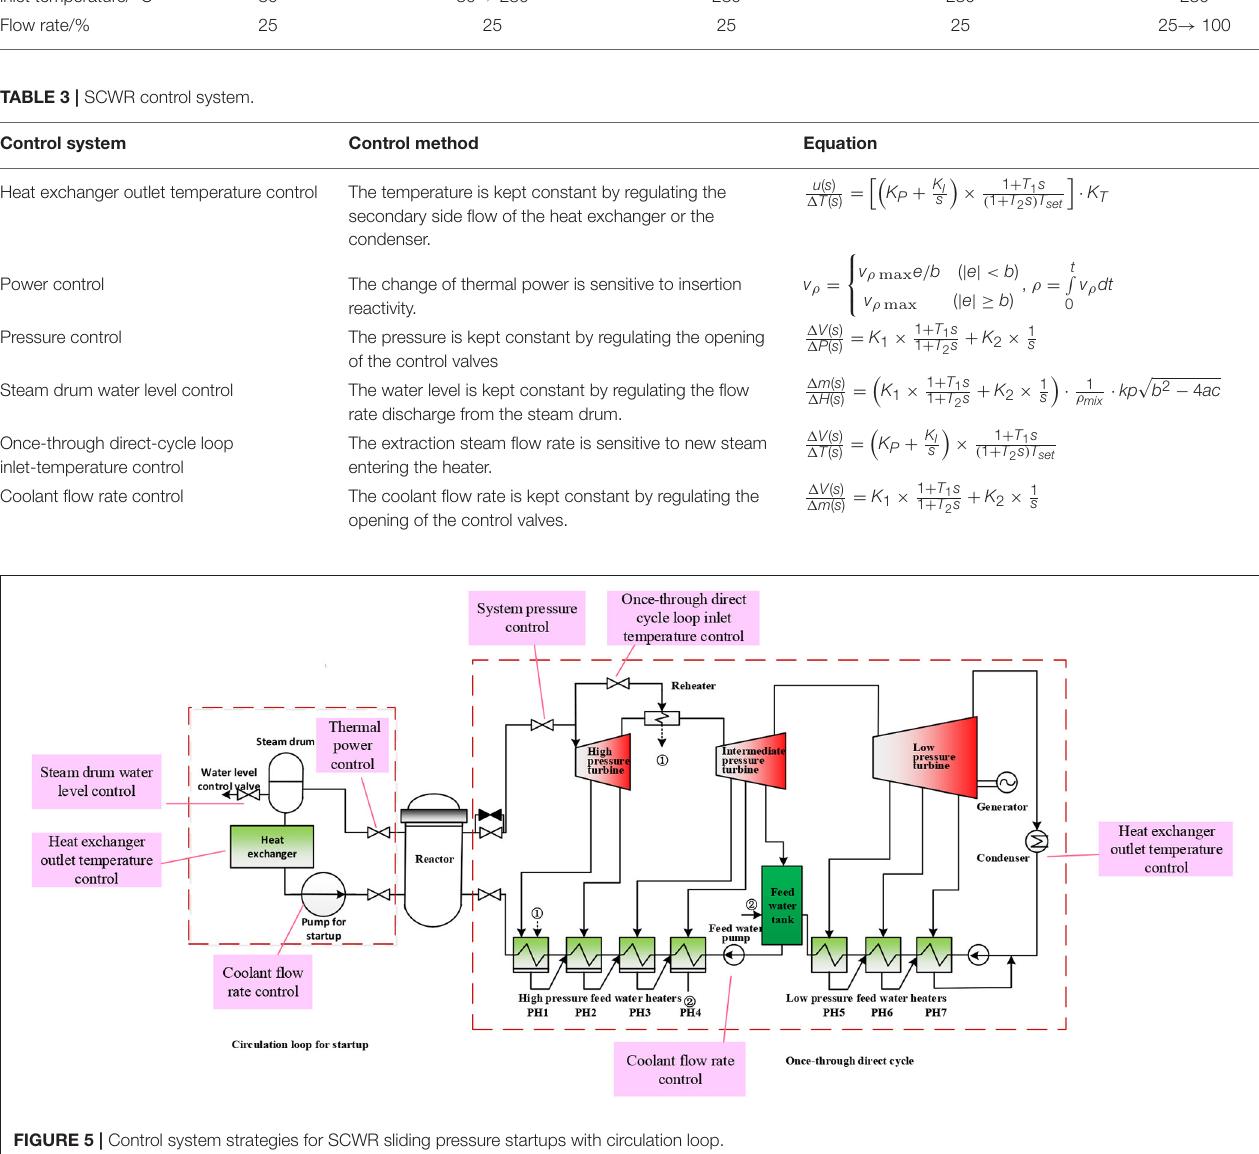
Frontiers in Energy Research |